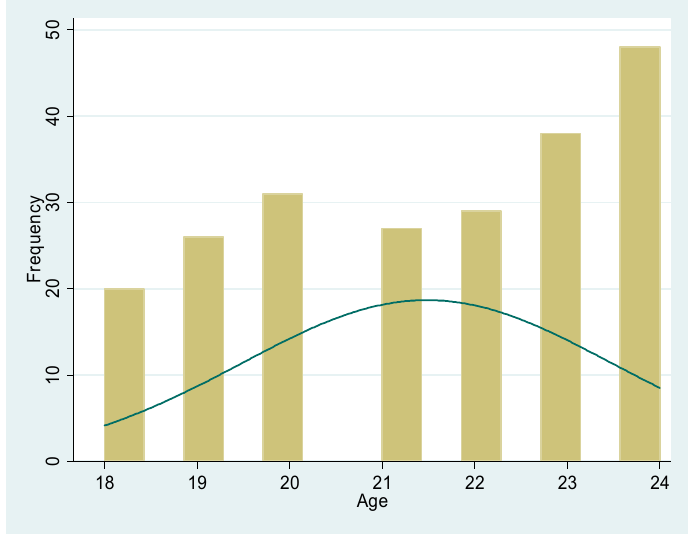
Figure 2. Age distribution of participants.